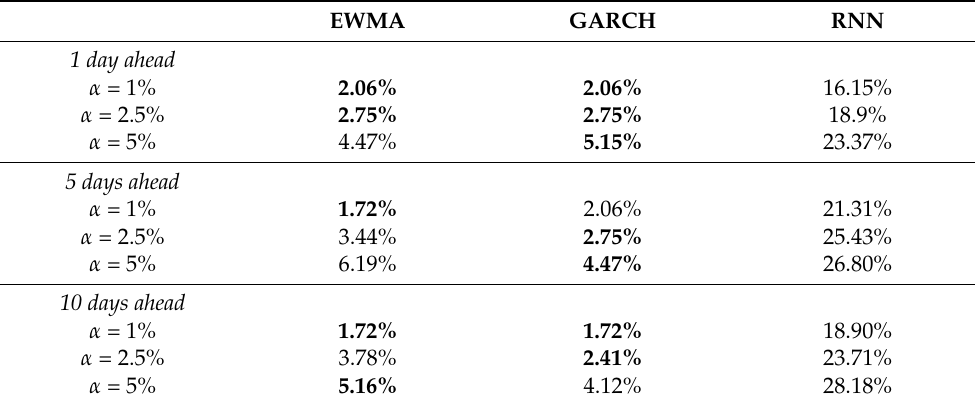
Table 6. Out of Sample Coverage of Each Model.